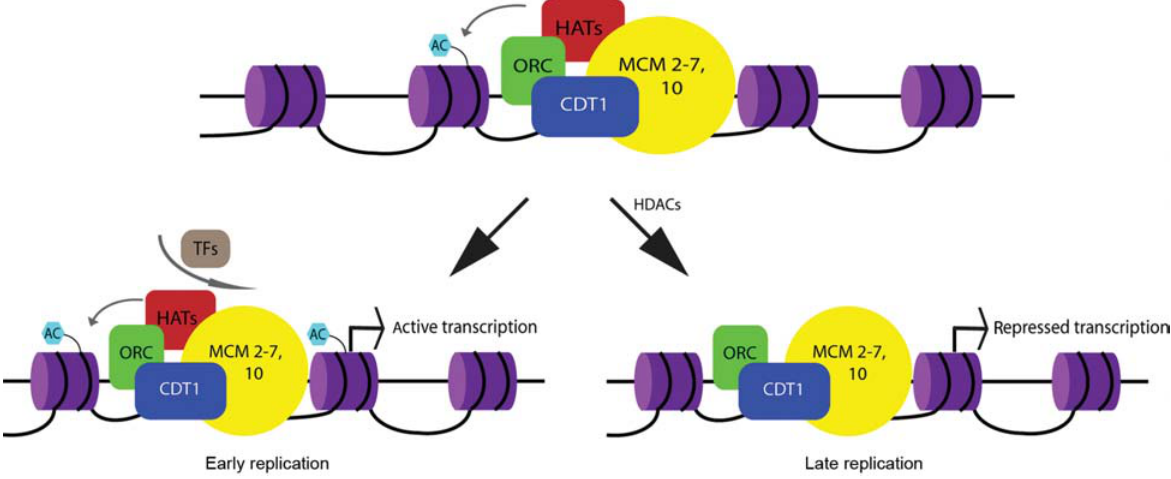
Figure 2 Molecular mechanisms of epigenetic replication. The ORC complex binds to an origin of replication in proximity to a promoter region (gray rectangle). By an interplay between histone acetyltransferases (HATs), which acetylate surrounding nucleosomes, and transcription factors (TFs), the pre-RC activation is facilitated. Thus, early origin firing and an active transcription are promoted. Contrariwise leads the activity of HDACs to deacetylation and late